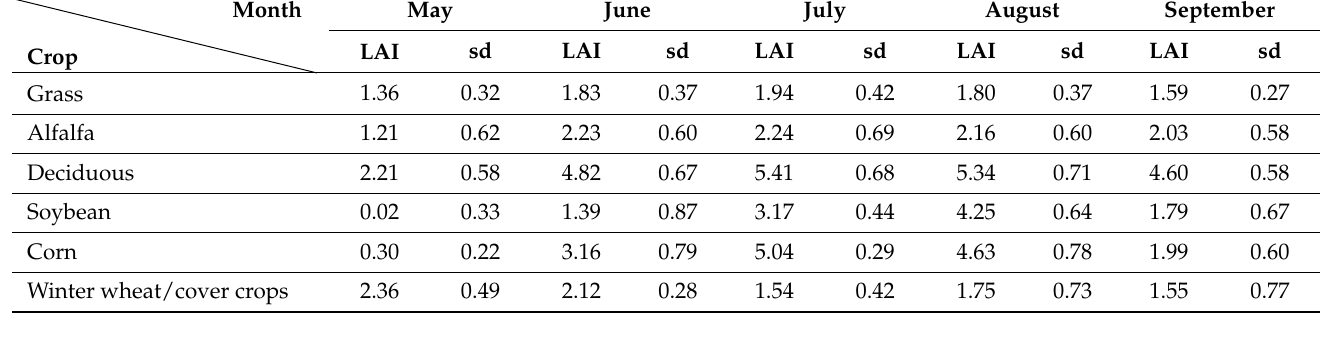
Table 5. Monthly mean LAI values (LAI) and standard deviations (sd) for the key crop types in the watershed during the 2018 growing season.